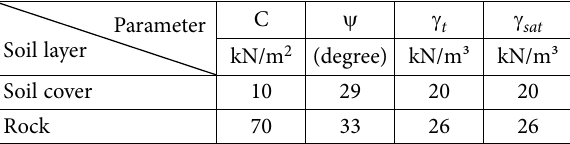
Table 3. Parameters of side slope stability analysis